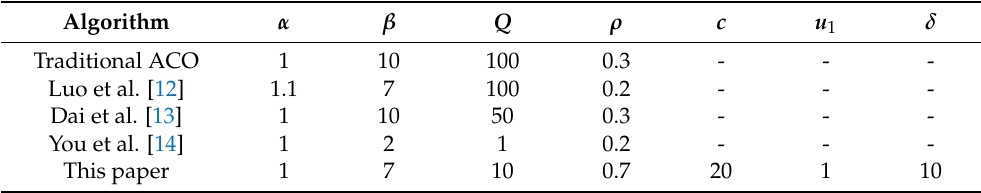
Table 2. Main parameters of the simulation experiment.